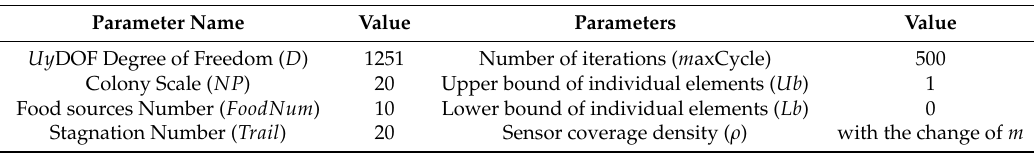
Table 2. The parameters of the IABC